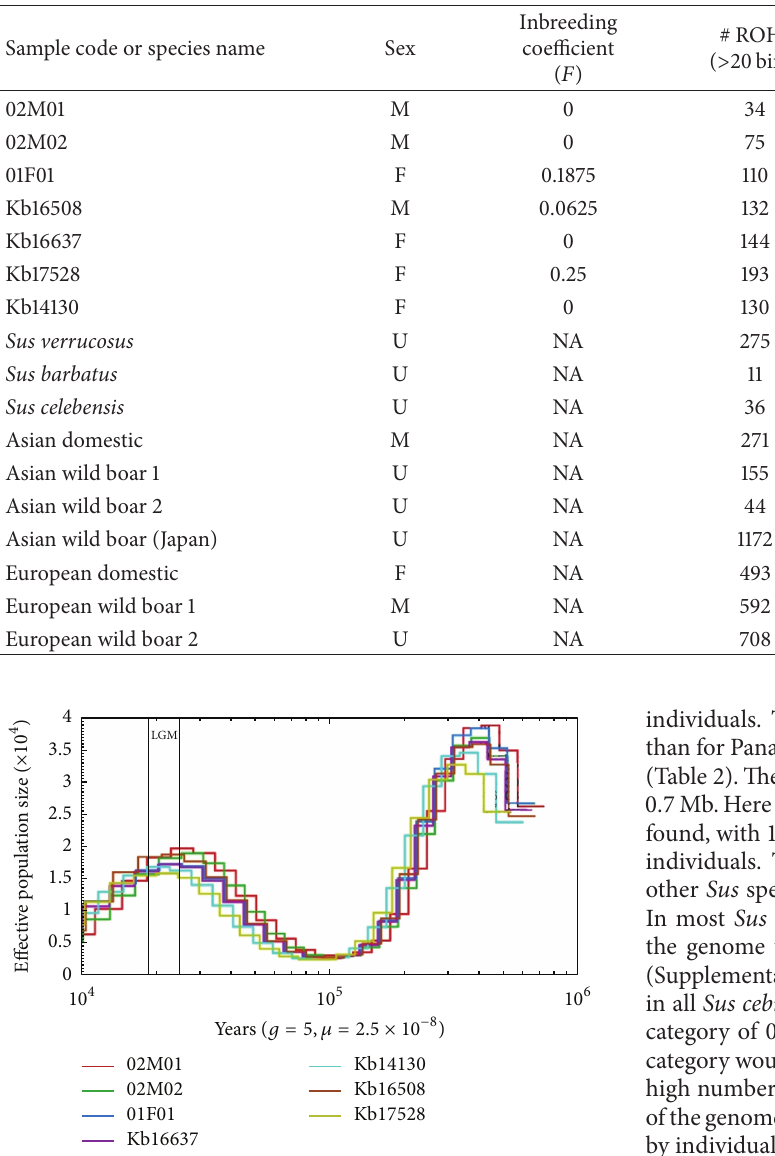
Table 2: Overview of number of ROHs, average length of ROHs, and nucleotide diversity outside ROHs for all Sus cebifrons individuals and other Sus individuals. Description of other Sus species is in Supplementary Material, Table S1. Asian wild boars 1 and 2 originate from north China and south China, respectively. European wild boars 1 and 2 represent populations from Italy and France, respectively.